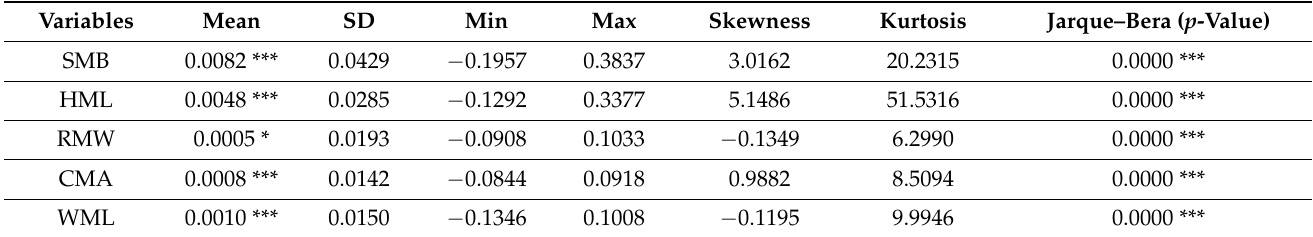
Table 1. Descriptive Statistics for Factor